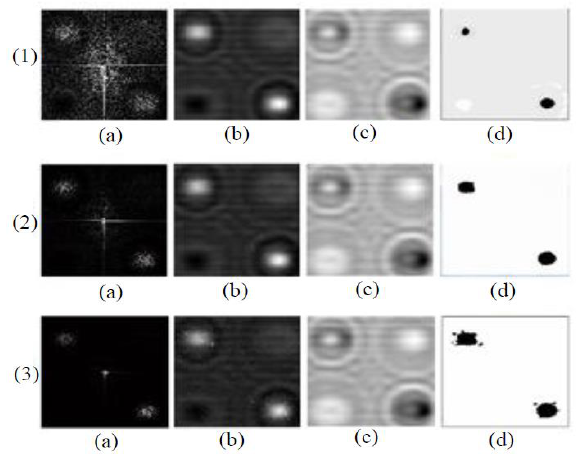
Figure 13. The total process of target segmentation of the sample, using Fourier transform and Wavelet transform, followed by Multi-thresholding and erosion, with (1) single, (2) two-fold, and (3) three-fold multiplications, ( a ) Fourier transforms, ( b ) inverted Fourier transforms (magnitude), ( c ) inverted Fourier transforms (phase), and ( d ) segmented results.